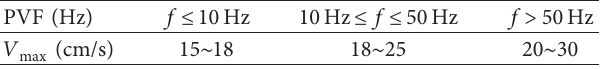
Table 6: Vibration velocity requirement for a roadway.